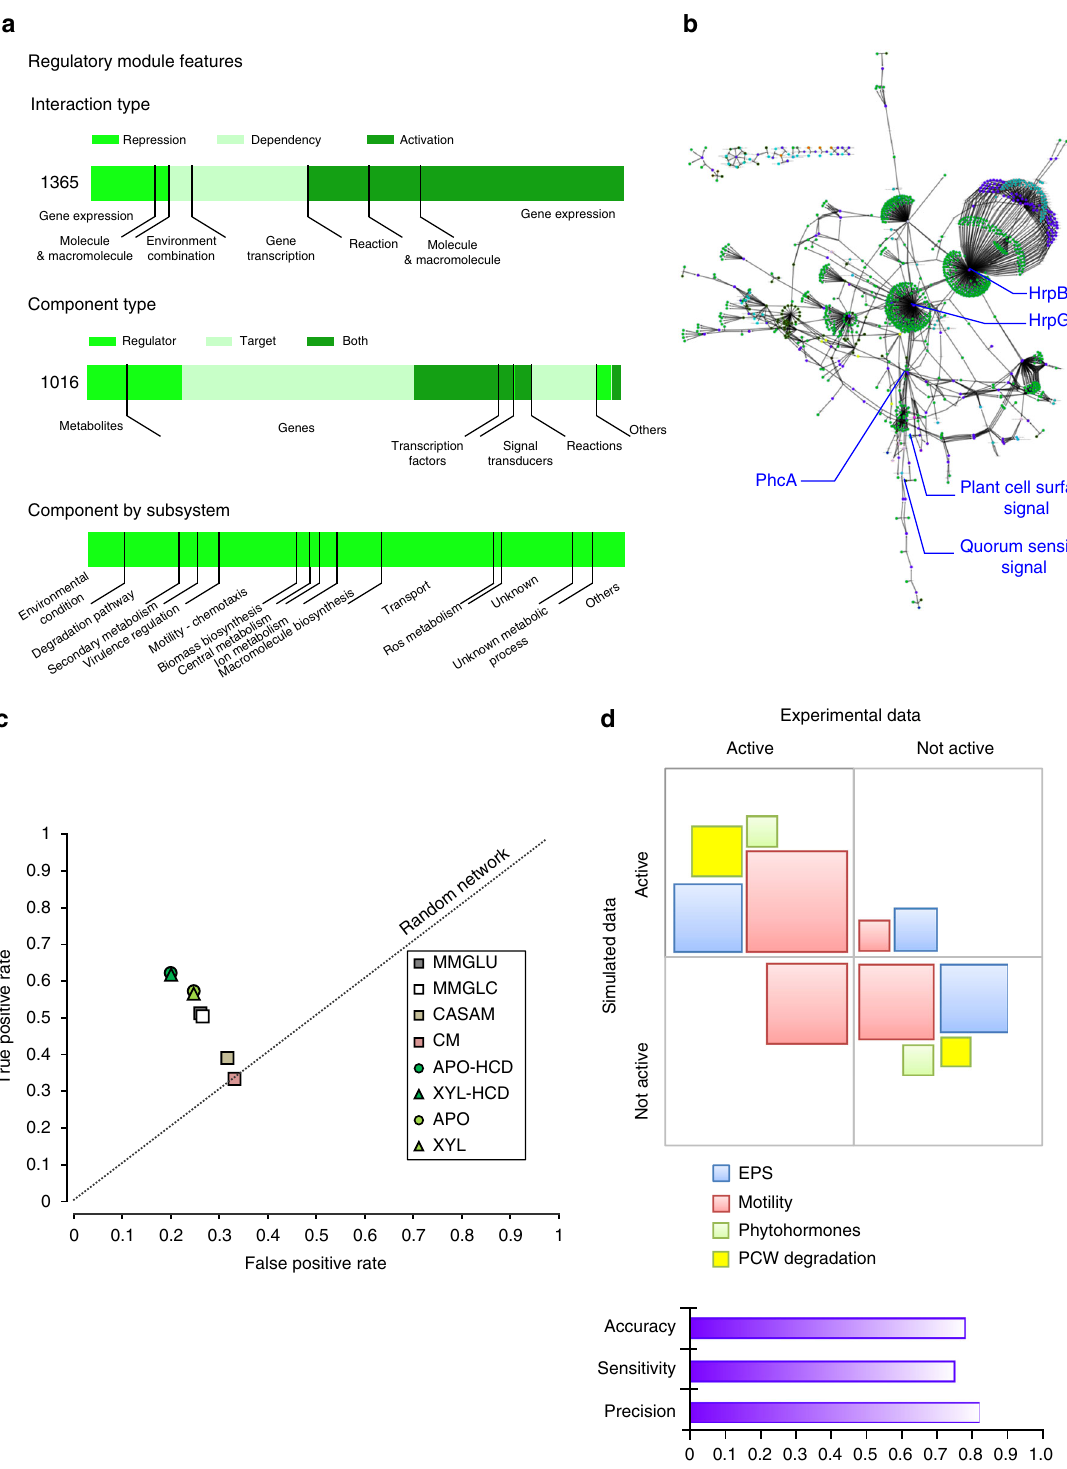
Fig. 3 Properties of the VRN and prediction performance. a Compositions and metrics of the virulence regulatory network. b View of the VRN structure with the three major regulatory hubs: PhcA, HrpG, HrpB (see detail in text). c Prediction capacity of the VRN on differential gene expression compared by an accuracy analysis to an in planta transcriptomic data set 50 . Environmental conditions used for simulation: MMGLU minimal medium with L -glutamate, MMGLC minimal medium with D -glucose, CASAM minimal medium with casamino acids, CM complete medium, APO tomato apoplast, XYL tomato xylem, HCD high-cell density. d Phenotype prediction of the cell-scale model (biochemical reaction network plus regulatory network) compared to experimental data for four groups of phenotypes and VRN deletion mutants in various conditions. The term “ active phenotype ” means that the corresponding biological function was either observed experimentally or inferred from simulation of the cell-scale model (i.e. possibility to realize a metabolic fl ux through the reaction associated to the phenotype). Size of the boxes is proportional to the number of phenotypes in each category ( n = 43). The metrics of the model performance are reported as precision, sensitivity and accuracy. EPS Exopolysaccharide production, PCW plant cell